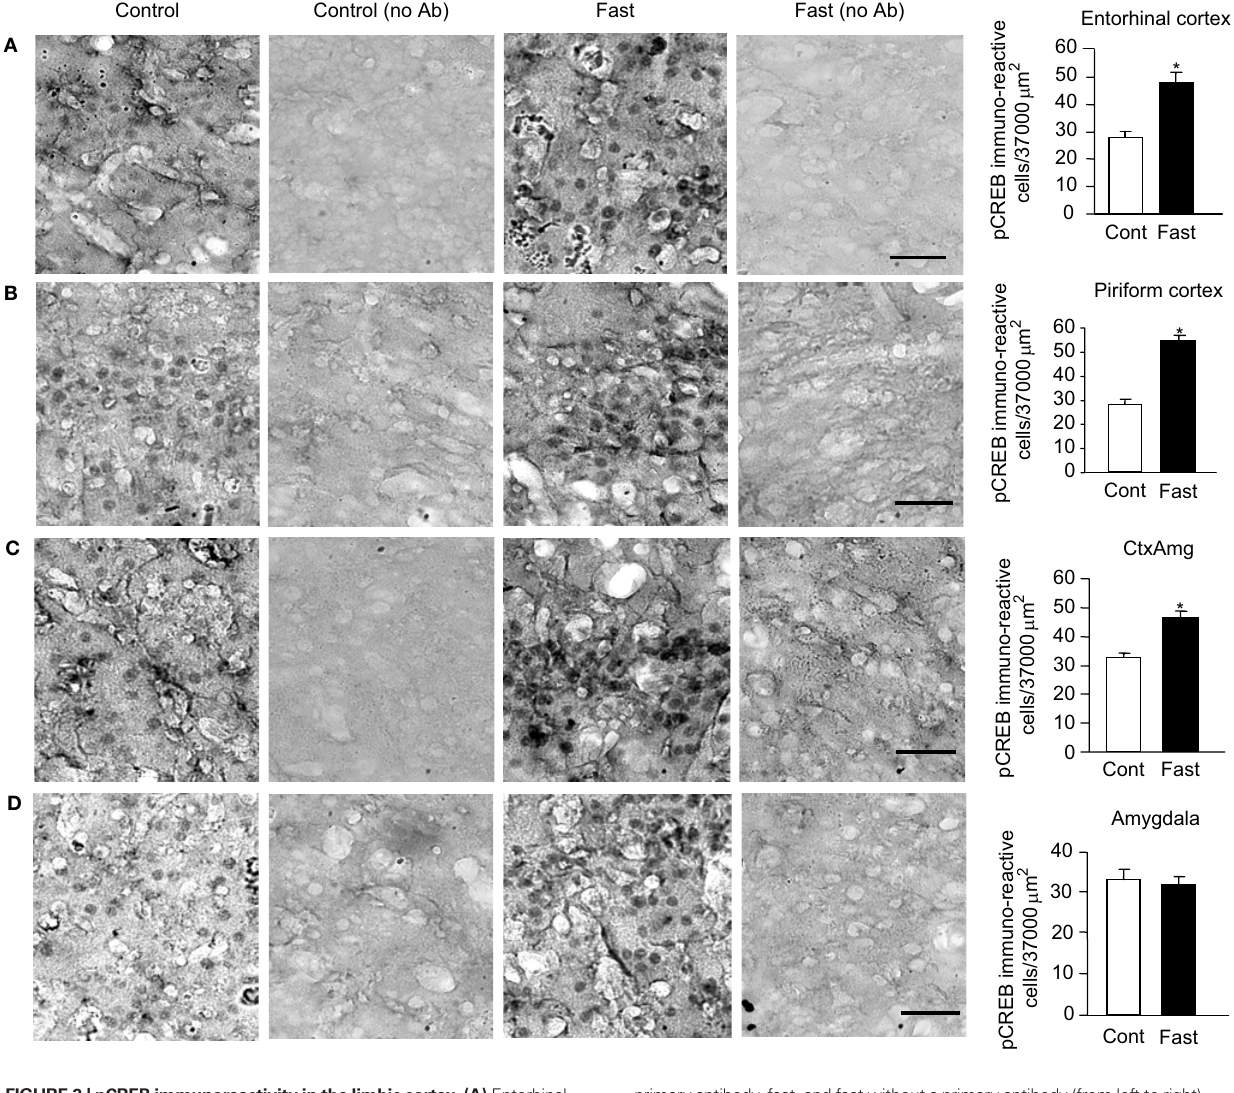
FIGURE 3 | pCREB immunoreactivity in the limbic cortex. (A) Entorhinal cortex. (B) Piriform cortex. (C) Cortico-amygdala transitional zone. (D) Amygdala. Photomicrographs in (A) – (D) were obtained from control, control without a